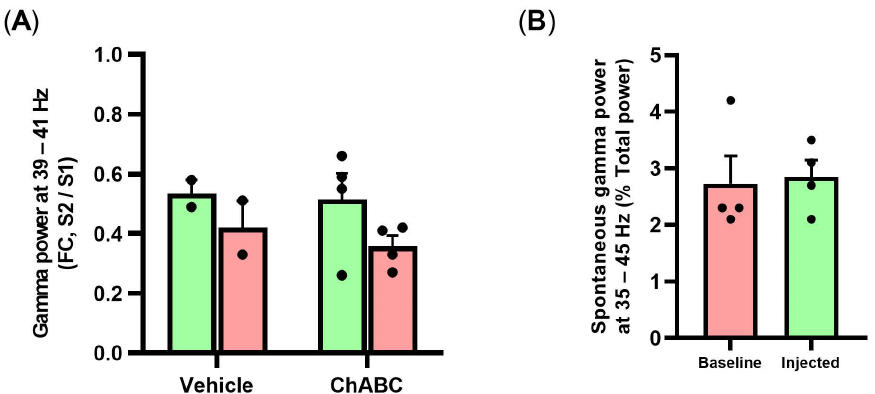
Figure 7. Prepulse inhibition test and spontaneous GBO in frontal cortex before and after ChABC injection. ( A ) Fold change during the S2 period in comparison with the S1 period. ( B ) Spontaneous GBO (35–45 Hz) was normalized by total power (0.5–1000 Hz). Data are expressed as mean ±